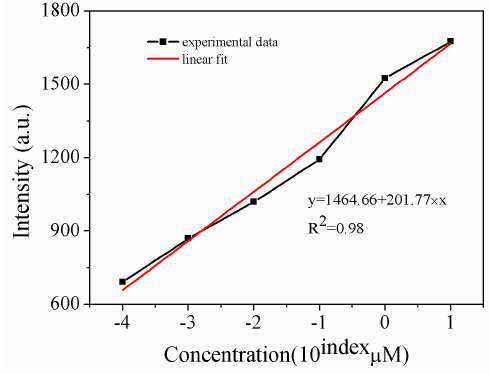
Figure 12. The fitting graph of the RRA-DNA concentration and fluorescence intensity.